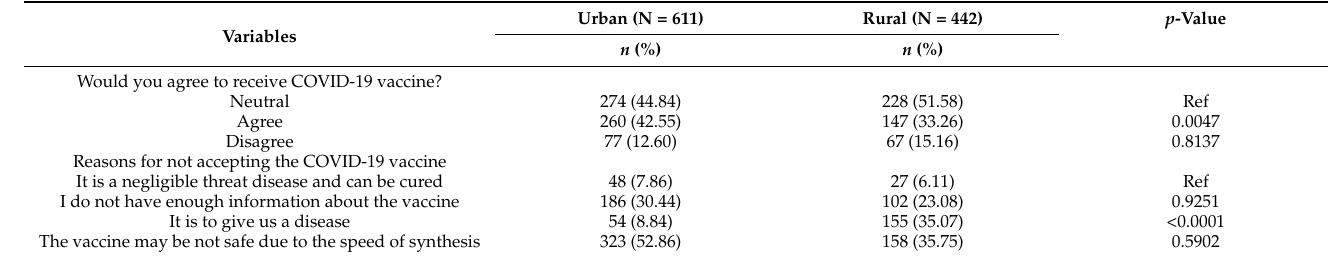
Table 3. Distribution of the respondents according of anti-COVID-19 vaccine.